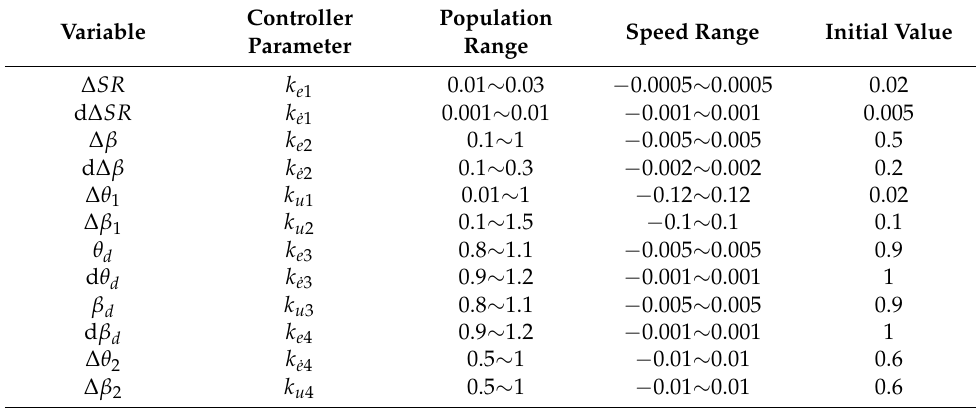
Table 8. Parameters of the double adaptive fuzzy